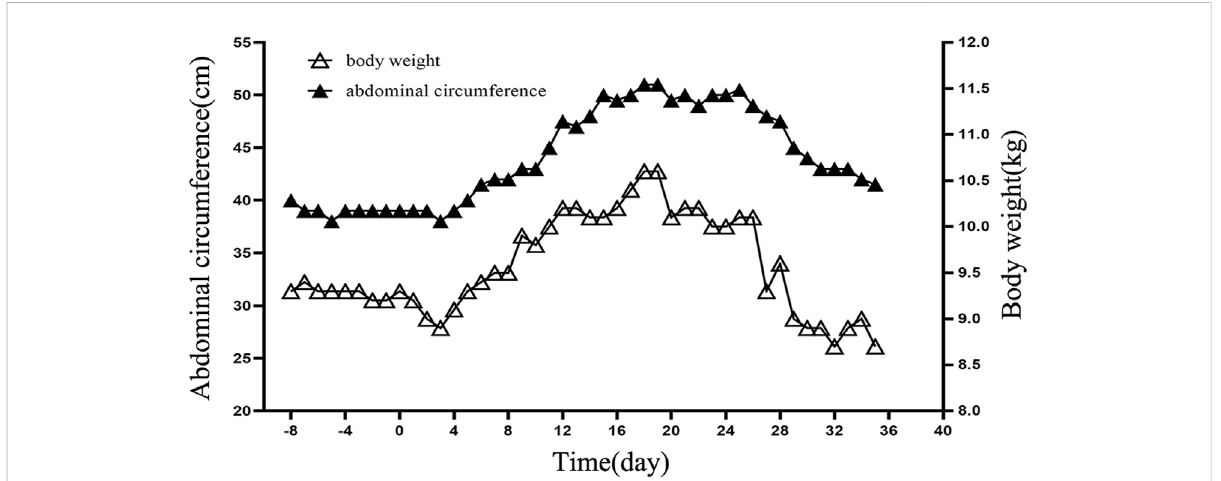
FIGURE 1 Details of changes in body weight and abdominal circumference. The X -axis represents time, with negative values indicating days before transplantation and positive values indicating days after transplantation. For example, − 8 for 8 days before transplantation and 20 for 20 days after transplantation. The Y -axis on the left represents the abdominal circumference in centimetres. The Y-axis on the right represents the weight in kilograms.